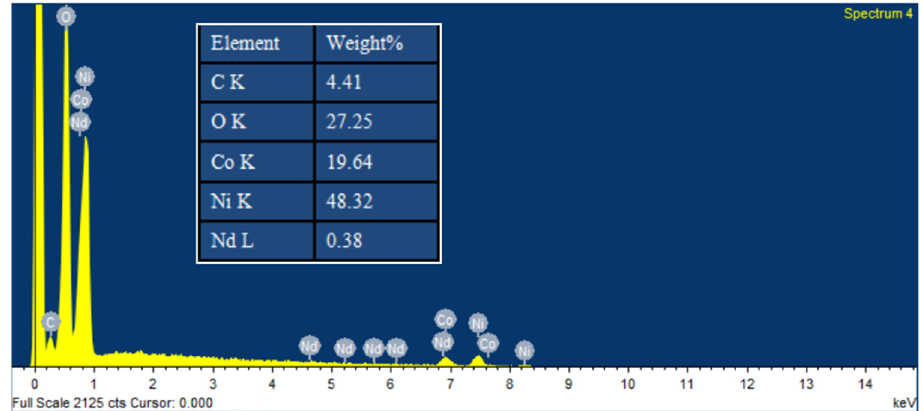
Figure 3. EDS of Nd 2 O 3 /Co 3 O 4 /rGO/NF.